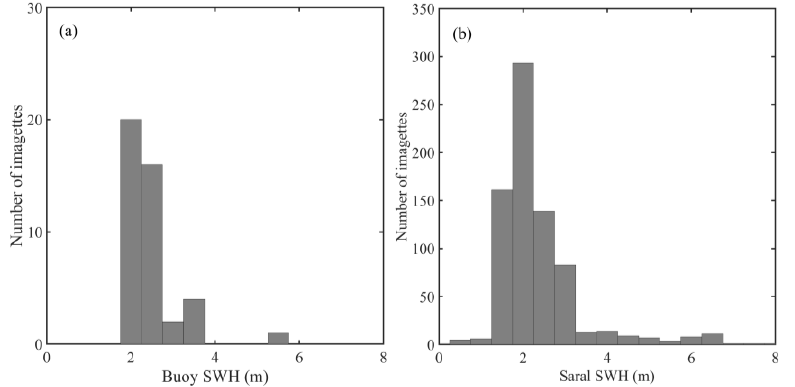
Figure 5. Histograms of the bouy SWH ( a ) and Saral SWH ( b ). The bin of the histograms is 0.4 m.